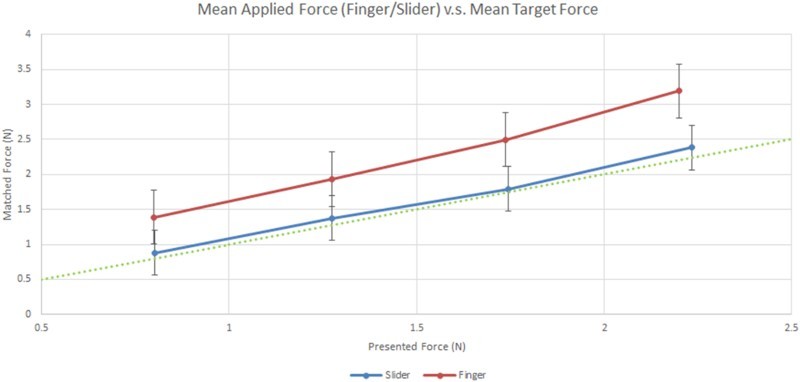
Comparison between mean difference of active and passive forces in the Finger and Slider conditions. The dotted line indicates perfect performance.